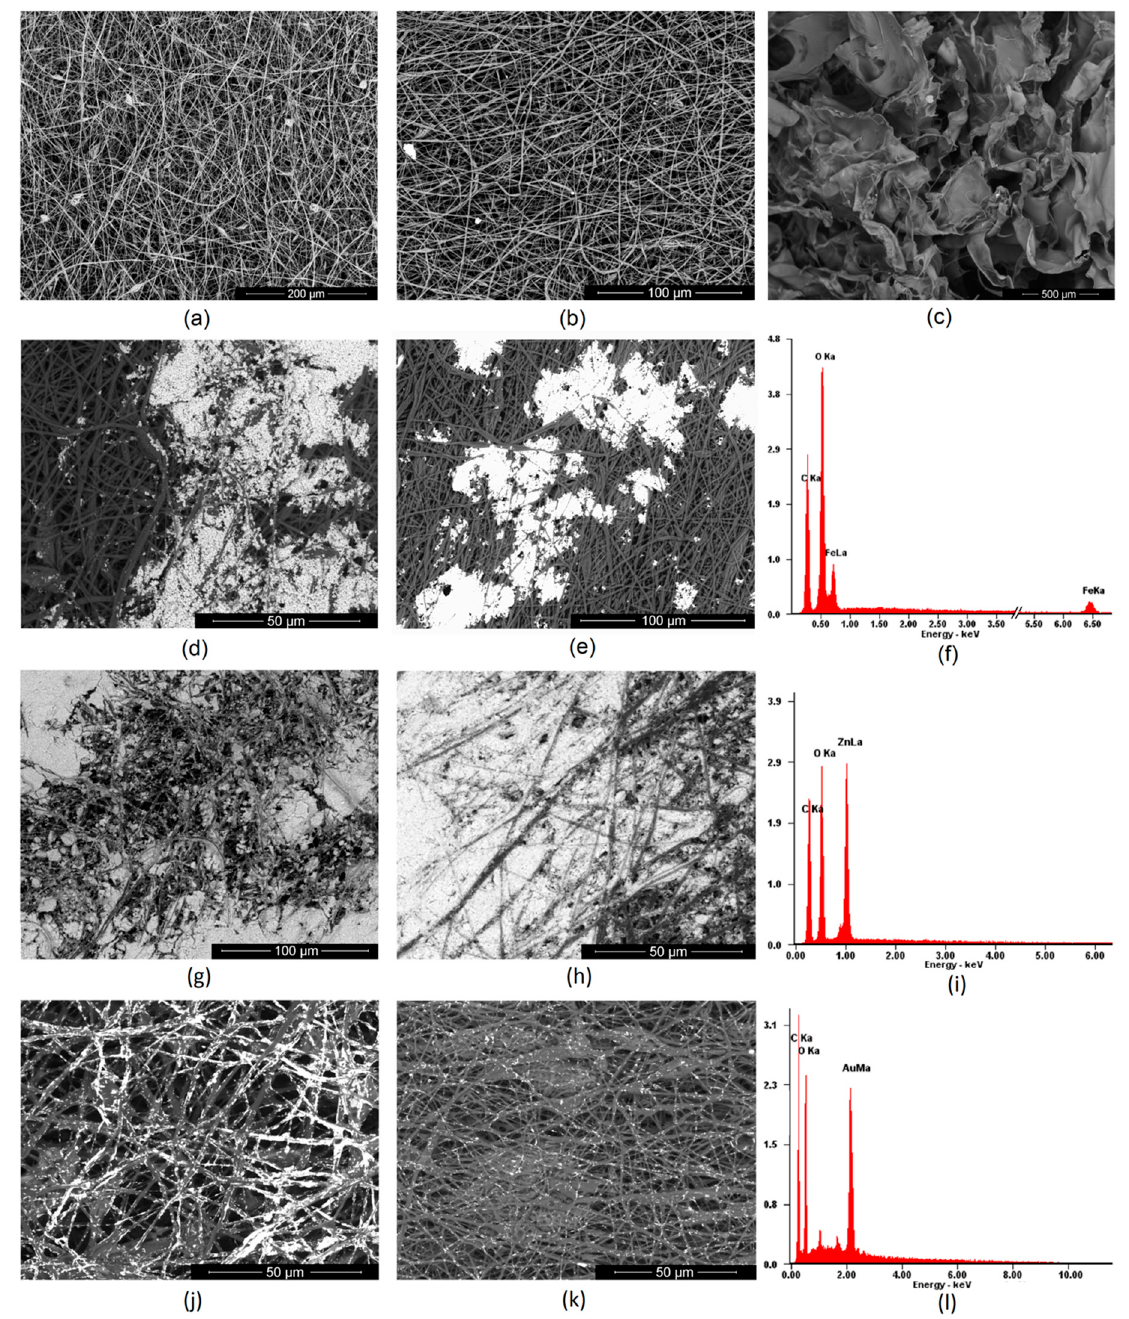
Figure 3. SEM images of the prepared nanofibers: ( a )—pure PLA nanofibers obtained under 30 kV; ( b )—pure PLA nanofibers obtained under 35 kV; ( c )—acylated chitosan; ( d )—PLA nanofibers obtained under 30 kV covered with Fe 3 O 4 nanoparticles; ( e )—PLA nanofibers obtained under 35 kV covered with Fe 3 O 4 nanoparticles; ( f )—XRF analysis of the surface composition ( g )—PLA nanofibers obtained under 30 kV covered with ZnO nanoparticles; ( h )—PLA nanofibers obtained under 35 kV covered with ZnO nanoparticles; ( i )—XRF analysis of the surface composition ( j )—PLA nanofibers obtained under 30 kV covered with Au nanoparticles ( k )—PLA nanofibers obtained under 35 kV covered with Au nanoparticles; ( l )—XRF analysis of the surface composition.